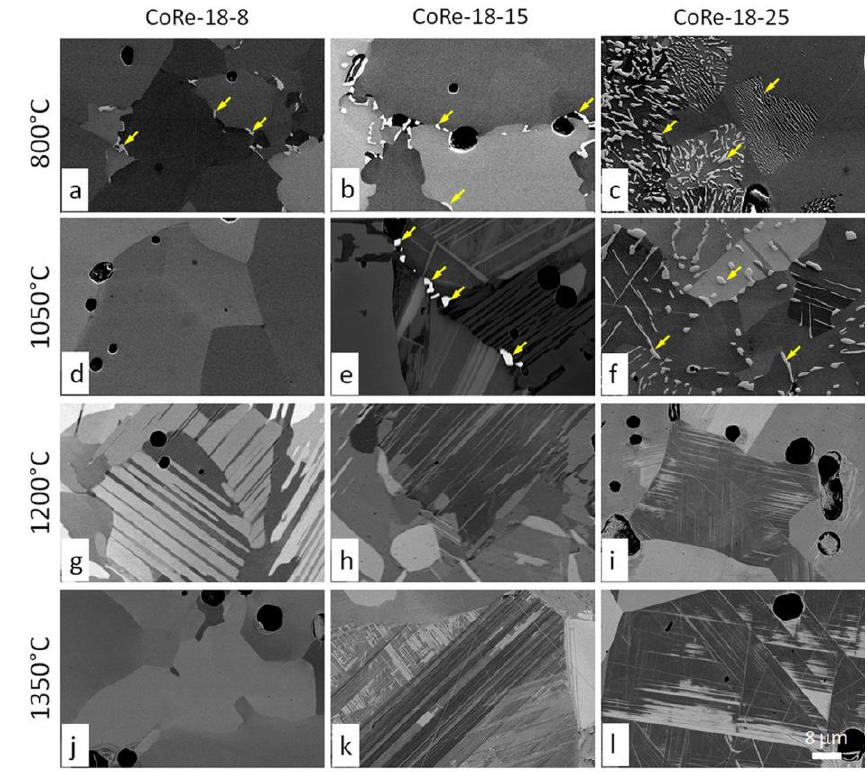
Figure 4. Microstructure of the 18% Cr alloys with varying Ni content (8–25%) after heat treatments at different temperatures: ( a ) 8Ni-800 ◦ C; ( b ) 15Ni-800 ◦ C; ( c ) 25Ni-800 ◦ C; ( d ) 8Ni-1050 ◦ C; at different temperatures: ( a ) 8Ni-800 °C; ( b ) 15Ni-800 °C; ( c ) 25Ni-800 °C; ( d ) 8Ni-1050 °C; ( e ) ( e ) 15Ni-1050 ◦ C; ( f ) 25Ni-1050 ◦ C; ( g ) 8Ni-1200 ◦ C; ( h ) 15Ni-1200 ◦ C; ( i ) 25Ni-1200 ◦ C; ( j ) 8Ni-1350 ◦ C; 15Ni-1050 °C; ( f ) 25Ni-1050 °C; ( g ) 8Ni-1200 °C; ( h ) 15Ni-1200 °C; ( i ) 25Ni-1200 °C; ( j ) 8Ni-1350 °C; ( k ) 15Ni-1350 ◦ C; ( l ) 25Ni-1350 ◦ C. All heat treatments: duration 100 ( k ) 15Ni-1350 °C; ( l ) 25Ni-1350 °C. All heat treatments: duration 100 h.